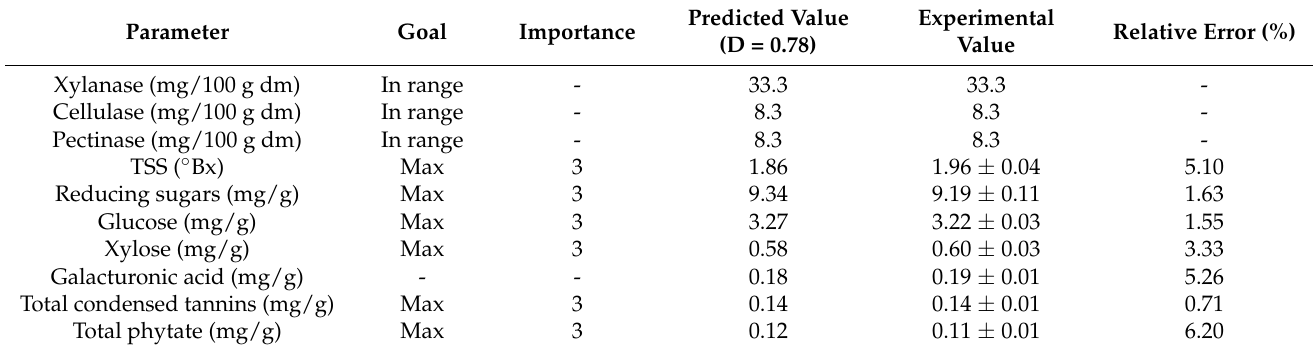
Table 4. Results of numerical optimisation to determine the optimal proportion of each enzyme in the cocktail, showing constraints, importance, predicted, and experimental values of the proportion of xylanase, cellulase, and pectinase in the enzyme cocktail, and the corresponding responses on the yield of pericarp constituents from sorghum grain following enzymatic pretreatment following Derringer’s prediction